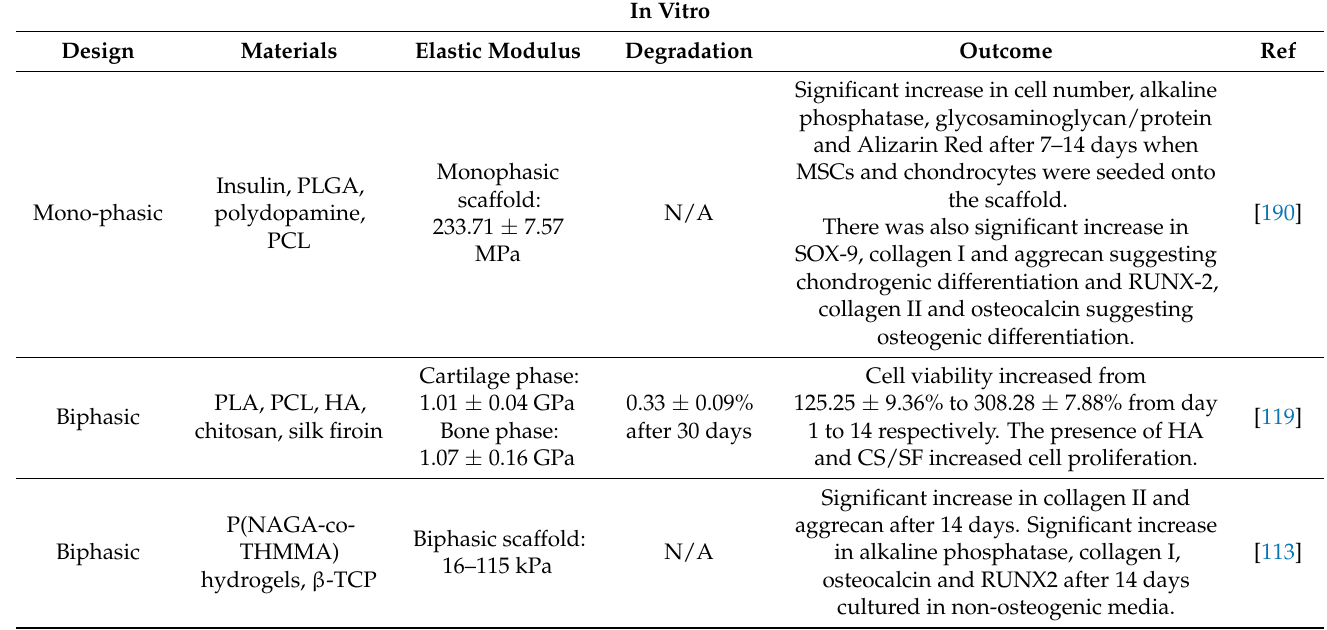
Table 3. In vitro models for the analysis of OC scaffolds. In